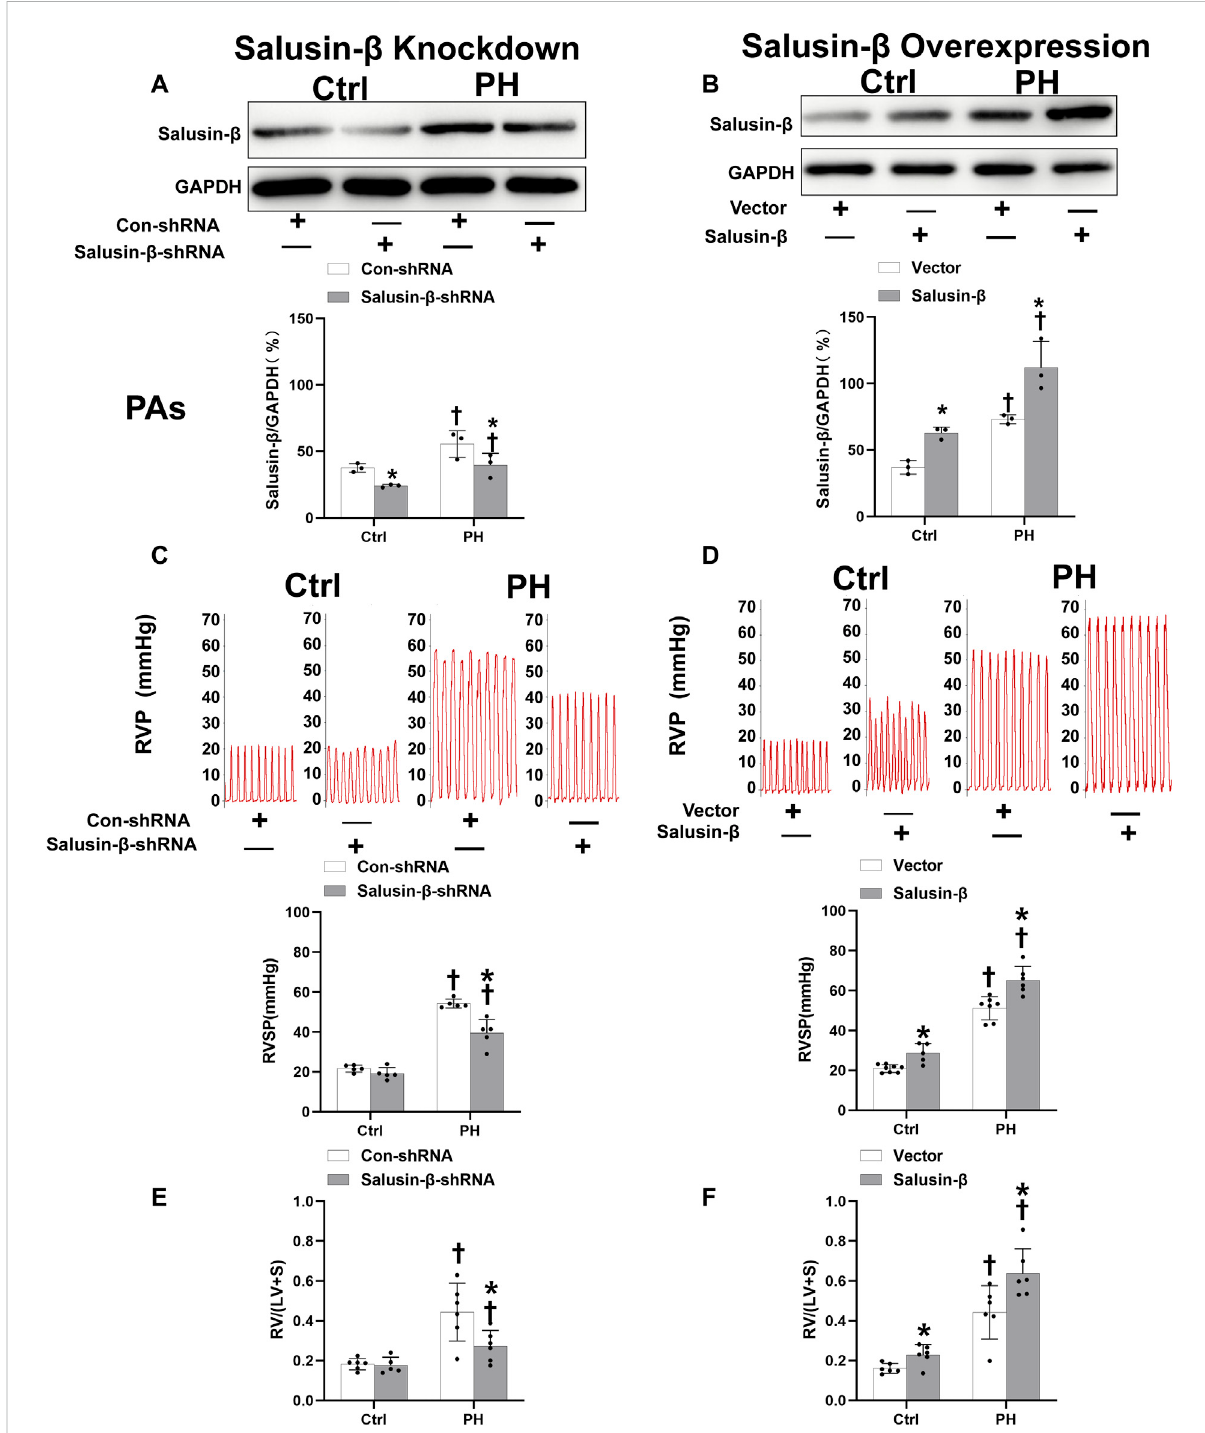
FIGURE 1 Effectsofsalusin- β knockdownonsalusin- β proteinexpressionsinPAs (A) ,rightventricularpressure(RVP)andrightventricularsystolicpressure (RVSP) (C) , and right ventricular hypertrophy index (RVHI) [RV/(LV + S)] (E) ; as well as the effects of overexpression of salusin- β on its protein expressions in PAs (B) , RVP and RVSP (D) , and RVHI (F) in control and MCT-induced PH rats. Values are mean ± SE. * p < 0.05 compared with Con- shRNA or vector. † p < 0.05 compared with control (Ctrl) rats. n = 5 – 8 for each